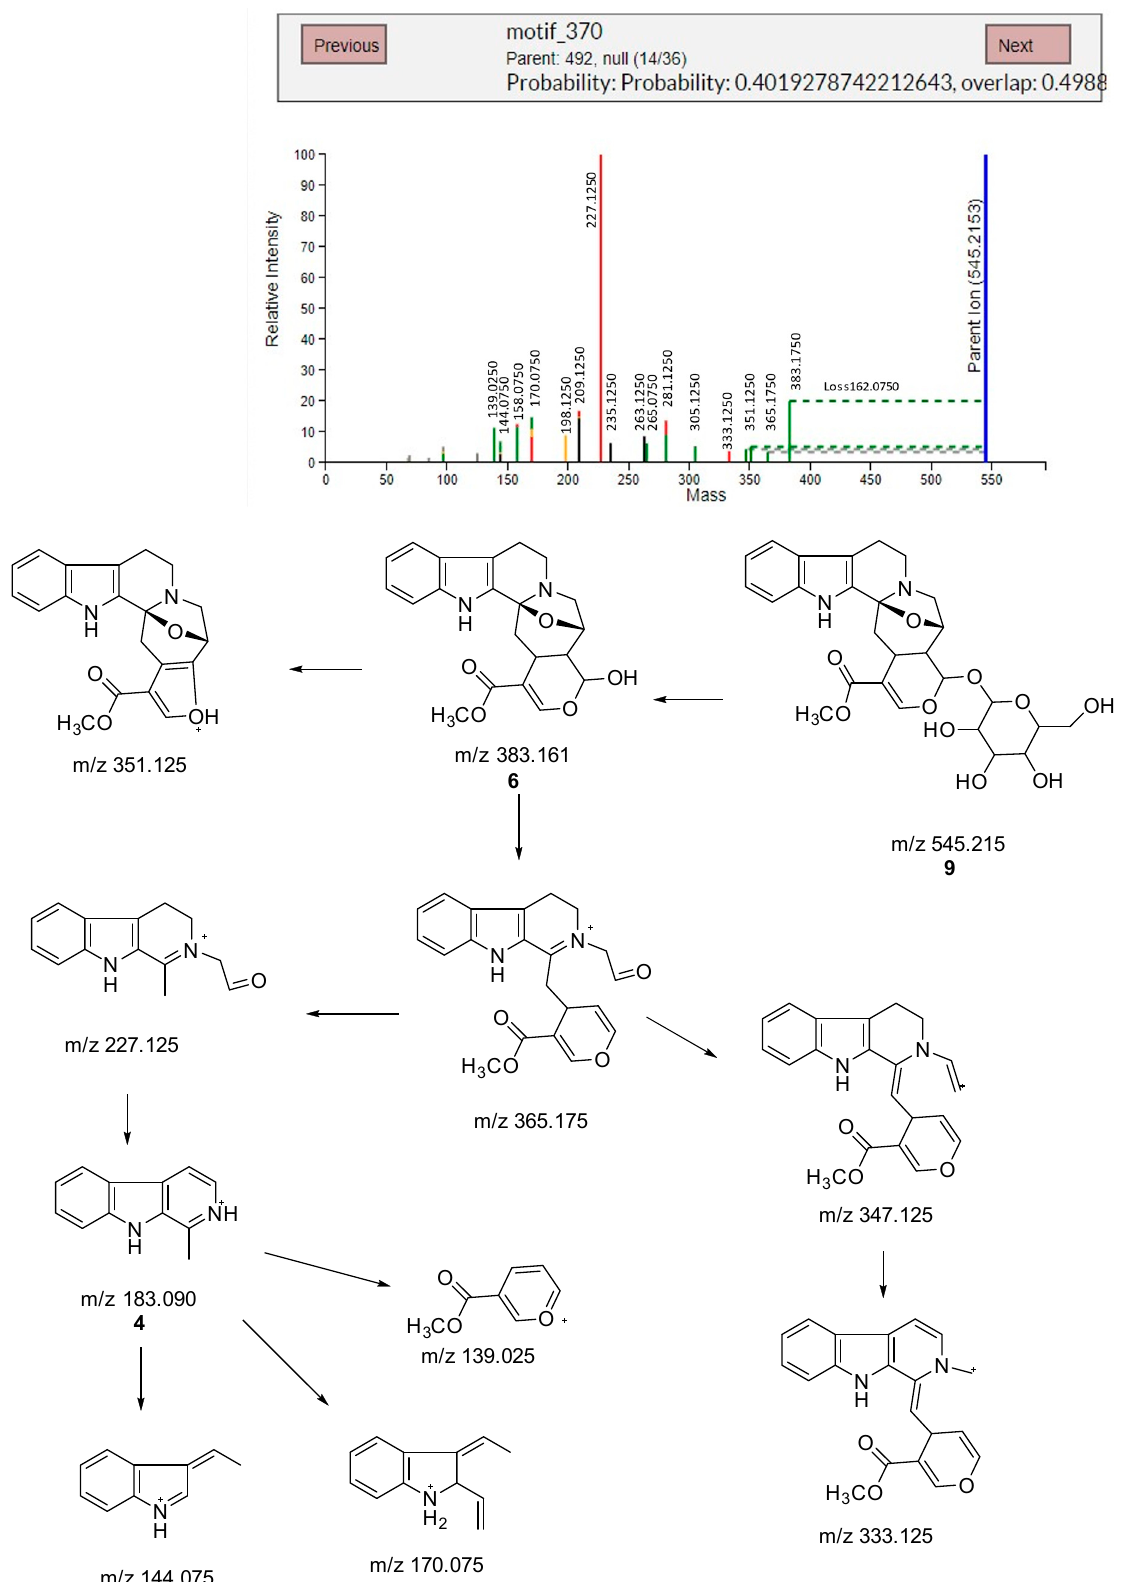
Figure 4. Mass spectra and fragmentation pathway of mass motif for parent 492.